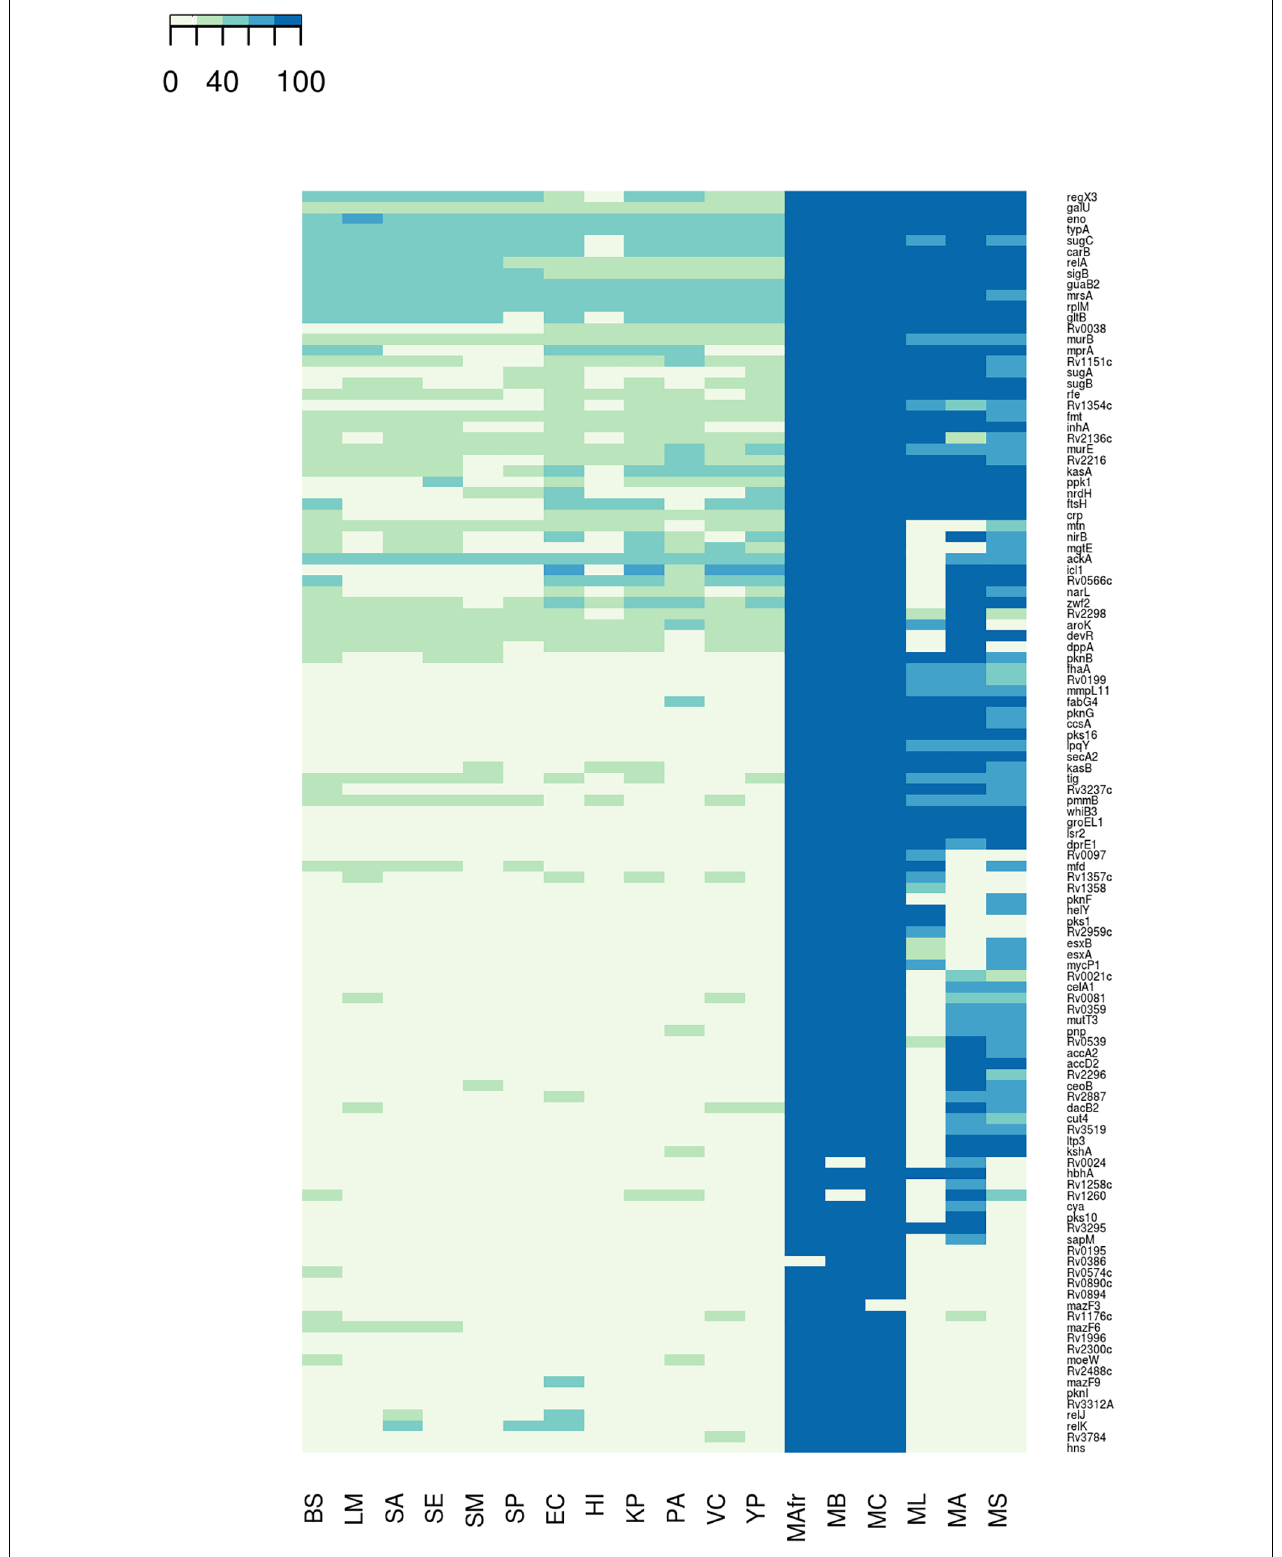
FIGURE 1 | Conservation of the biofilm- and quorum sensing-associated proteins (BQAPs) across bacterial genomes. Percent identities between the homologs are used for generating the heat map.